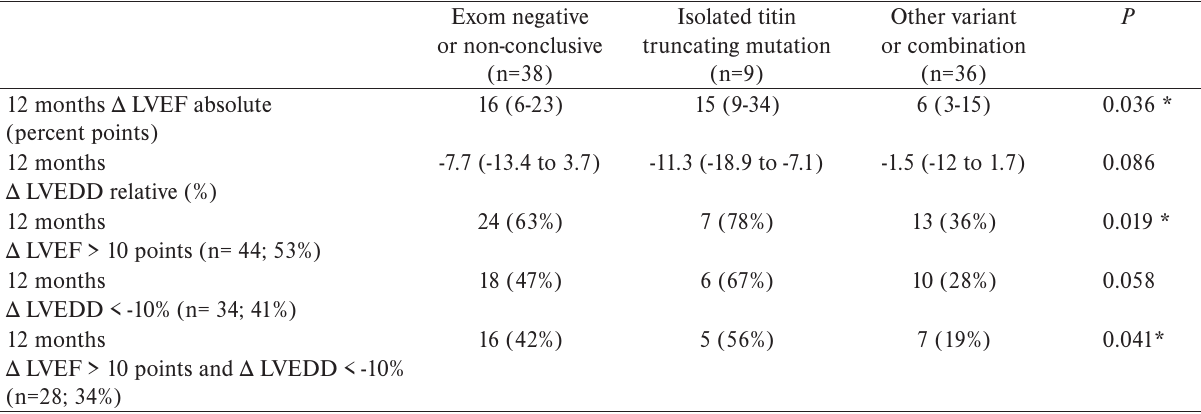
Table 2. Left ventricular reverse remodelling and results of